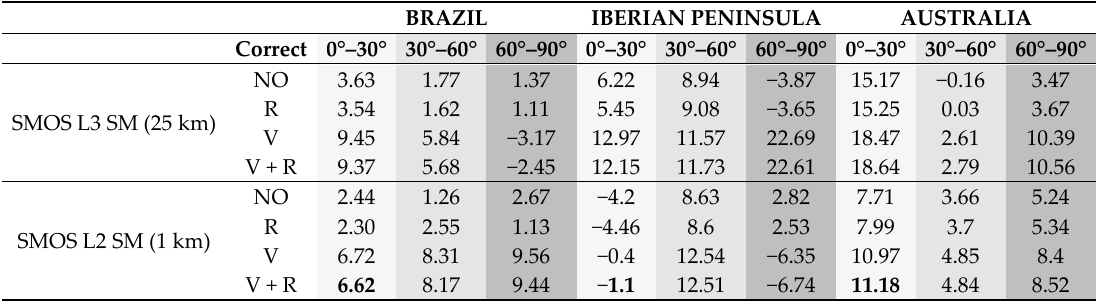
Figure 14. Scatter plot between the ( a ) Low Resolution (25 km) SMOS L3 SM and ( b ) High Resolution (1 km) SMOS L4 SM and the TDS-1 reflectivity value over the Iberian Peninsula from June 2016 to June 2017, with vegetation and roughness corrections applied. Each column represents the values for a specific range of incidence angles: ( left ) 0°–30°; ( center ) 30°–60°; and ( right ) 60°–90°. Table 3. Slopes of the regression lines shown in the Figures 13–15, and SMOS L2 SM (Low Resolutions) and SMOS L3 Soil Moisture (High Resolution). Note: NO” stands for no corrections applied, “R” for surface roughness correction applied only, “V” for vegetation corrections applied, and “V + R” for vegetation and surface roughness corrections applied. NO, R, and V cases not presented in Figures 13–15.